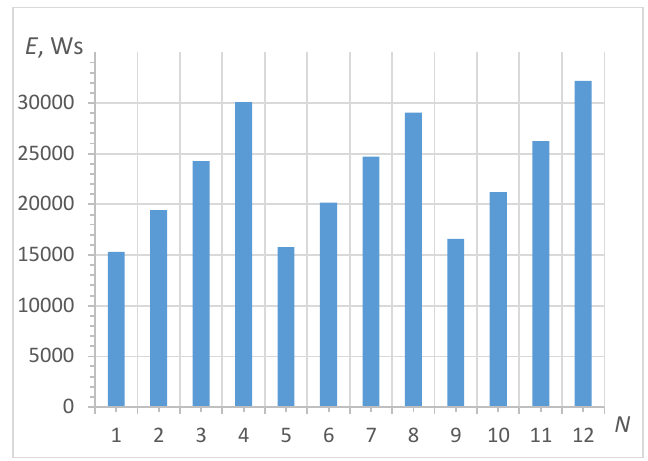
Fig. 10. Energy consumption for different quadcopters with an optimisation algorithm for 1000 m flight.